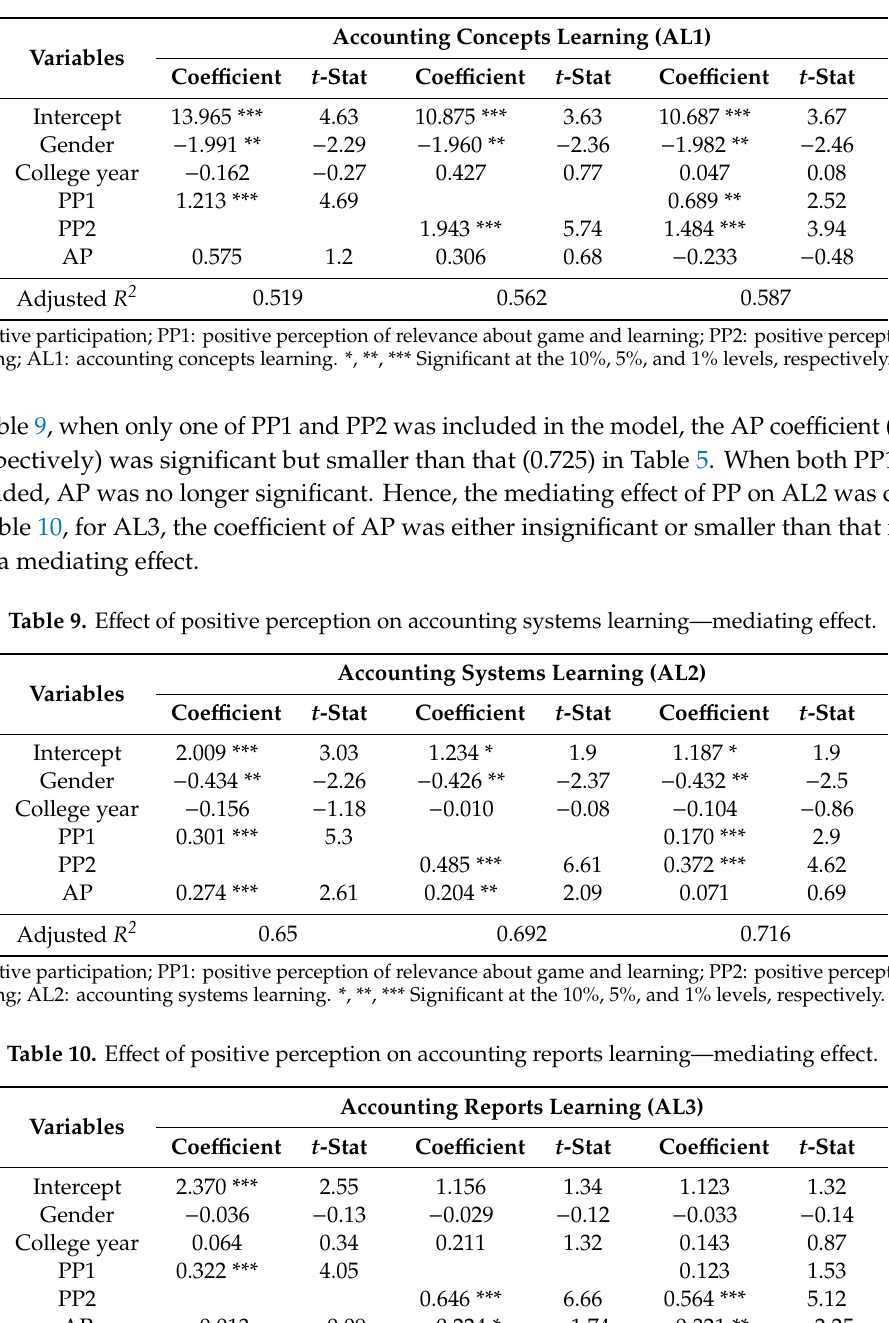
Table 8. E ff ect of positive perception on accounting concepts learning—mediating e ff ect.